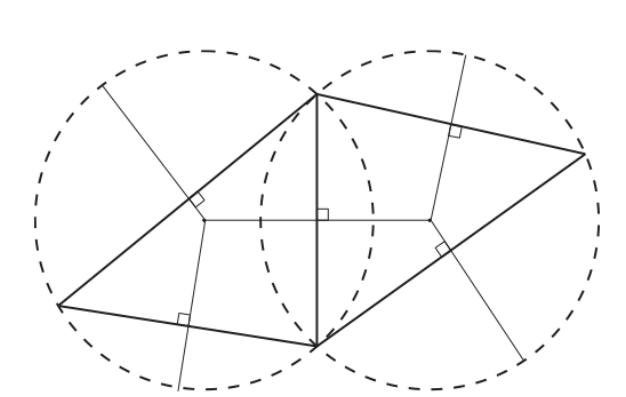
Fig. 8. Mesh orthogonality with acute